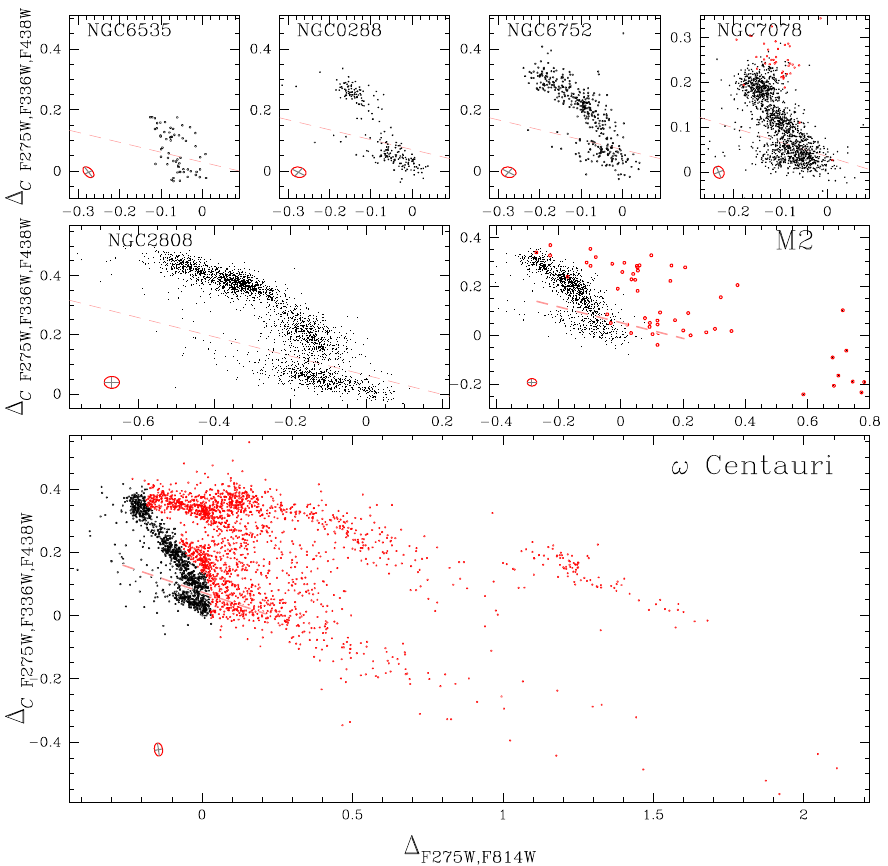
Figure 7. Chromosome maps for seven GCs. The dashed lines separate the bulk of 1P stars from the 2P. Red RGB stars are colored red. This figure illustrates the high degree of variety of the multiple population